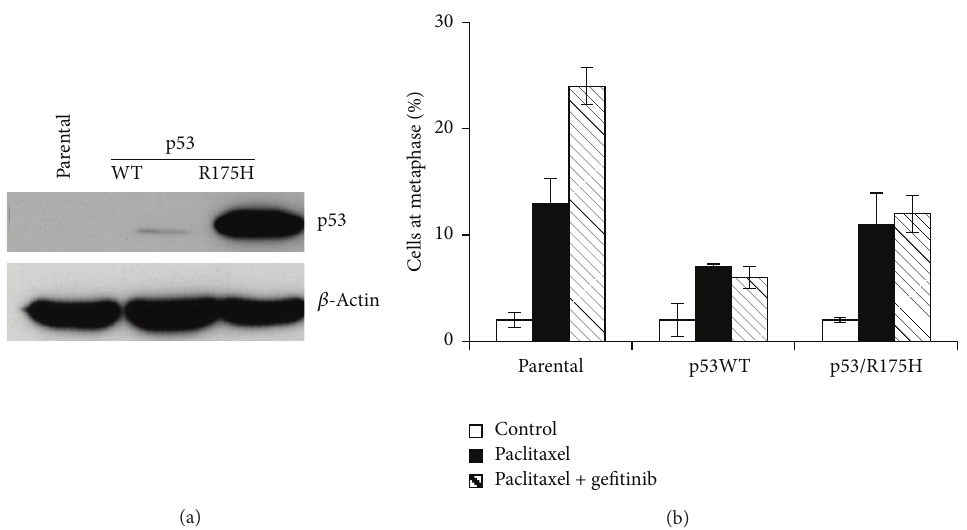
Figure 1: Synthetic lethality to paclitaxel + RTK inhibitor in endometrial cancer cells requires loss of functional p53 . Hec50 endometrial cancer cells which are p53-null were transfected with either WT p53 or GOF p53 mutant R175H, one of the most commonly observed p53 GOF mutations in cancer. (a) Expression of p53 in Hec50 cells by Western blotting. (b) Percentage of mitotic cells after treatment with paclitaxel (10nM) and/or EGFR inhibitor gefitinib (10 𝜇 M) for 24